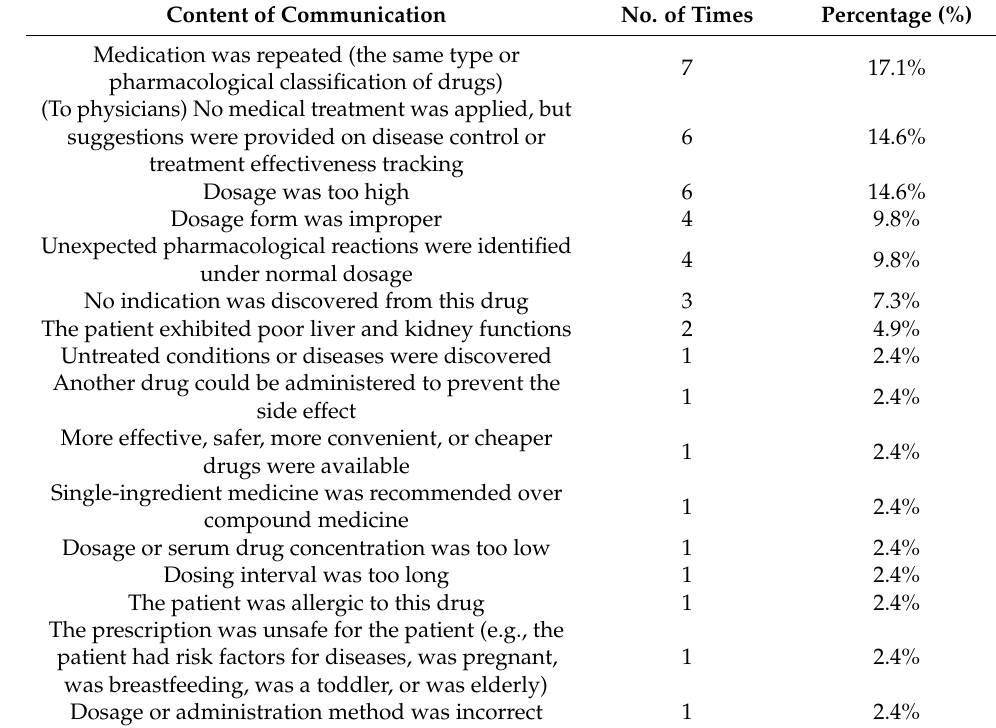
Table 6. Medication problems identified by the pharmacists ( N =